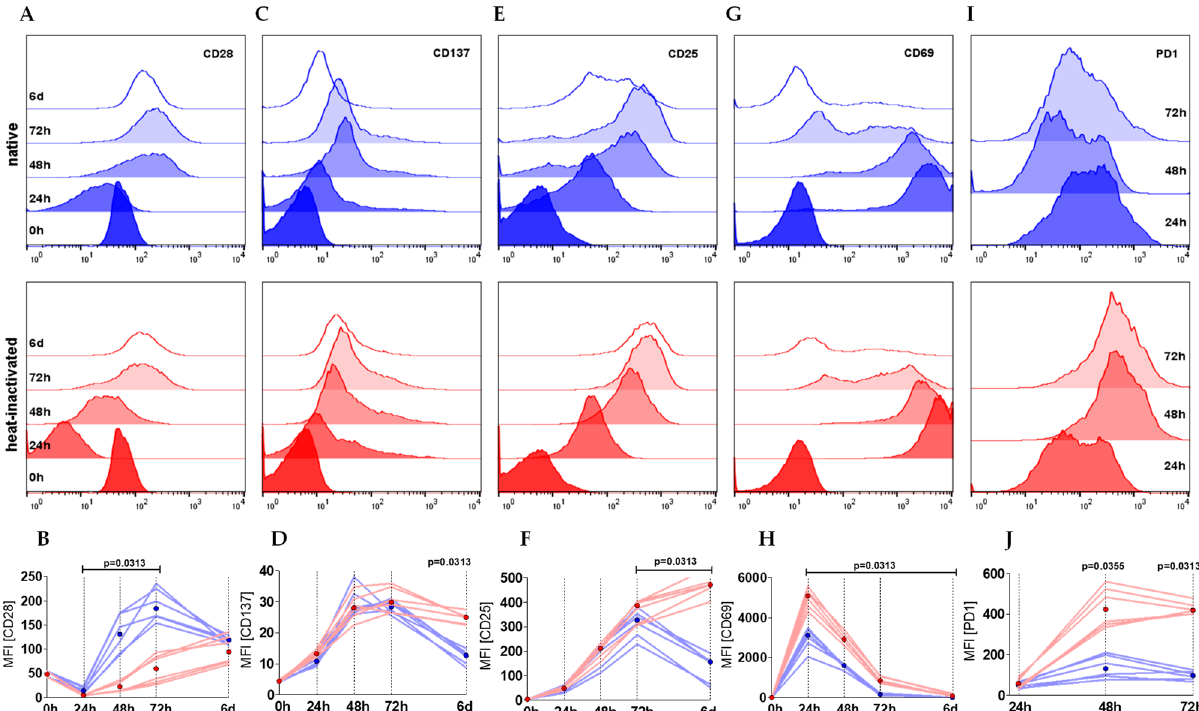
Figure 3. CD4+ T cells cultured in HI serum show a more activated phenotype in terms of surface marker expression. ( A – J ) T cells were stimulated either in native or HI serum. CD28 ( A , B ), CD137 ( C , D ), CD25 ( E , F ), CD69 ( G , H ), and PD-1 ( I , J ) are shown as ( A , C , E , G , I ) histogram plots representing a single representative experiment with one donor either cultured in native (blue) and heat-inactivated (red) serum within a time course of 6 days. ( B , D , F , H , J ) Depicted graphs show the median fluorescence intensity (MFI) of two individual donors in three different sera (six single experiments each represented by one line) with the dots showing the median of the native (blue) and HI (red) cultures (Wilcoxon test; shown are nominal p -values).